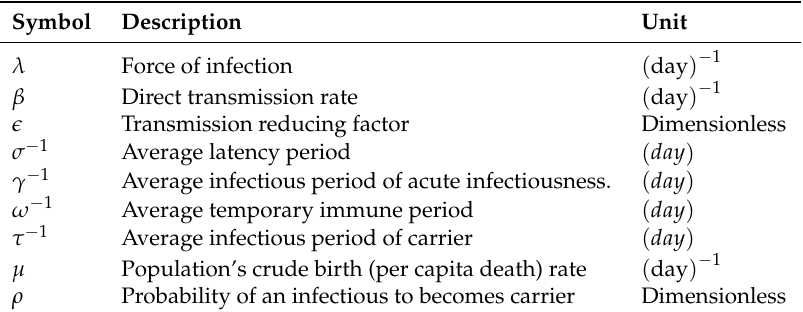
Table 1. Table of